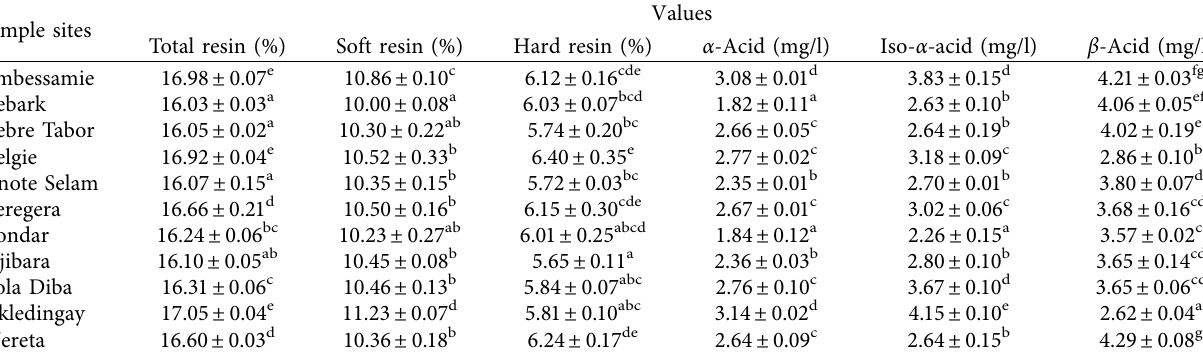
Table 1: Average concentrations of the bittering components in R. prinoides leaves samples collected from different sample sites. Sample